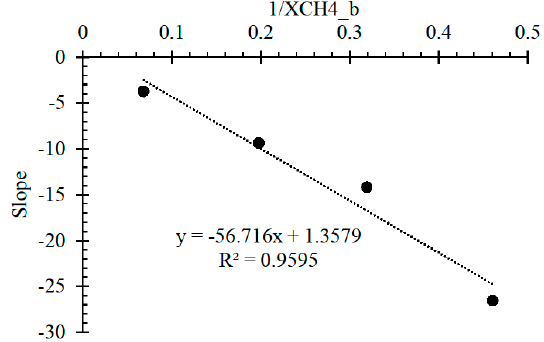
Figure 7. Inverse XCH 4_b (1/XCH 4_b ) versus slope of the lines in Figure 6c, calculated for data near α = 0 for the plume strength cases of k = 0.25, 1, 2.5, and 10.